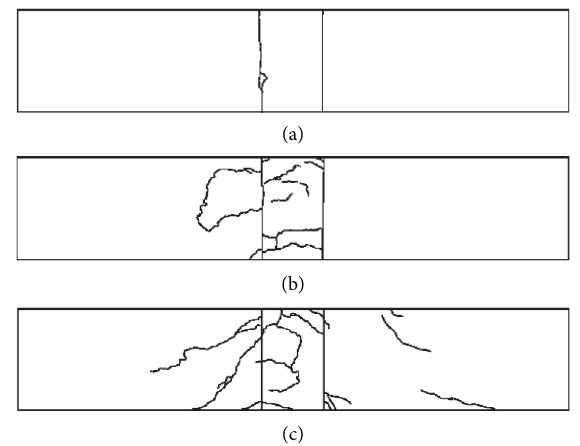
Figure 9: Crack pattern for specimens. (a) Type 1. (b) Type 2. (c) Type 3.